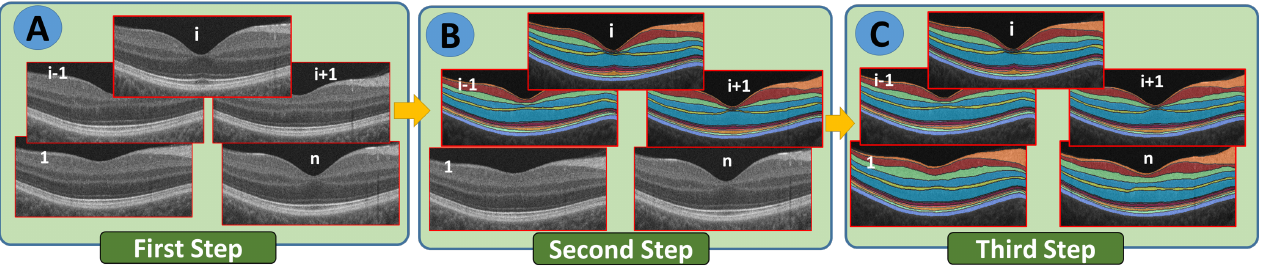
Figure 3. An explanation of the segmentation process shows how the B-scan 3D OCT images are segmented beginning at the macula mid slice ( i ) and moving in two directions ( A – C